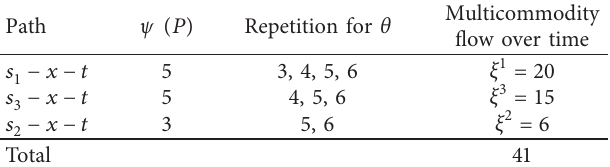
Table 3: EAMCT with partial lane reversals. Path ψ ( P ) Repetition for θ